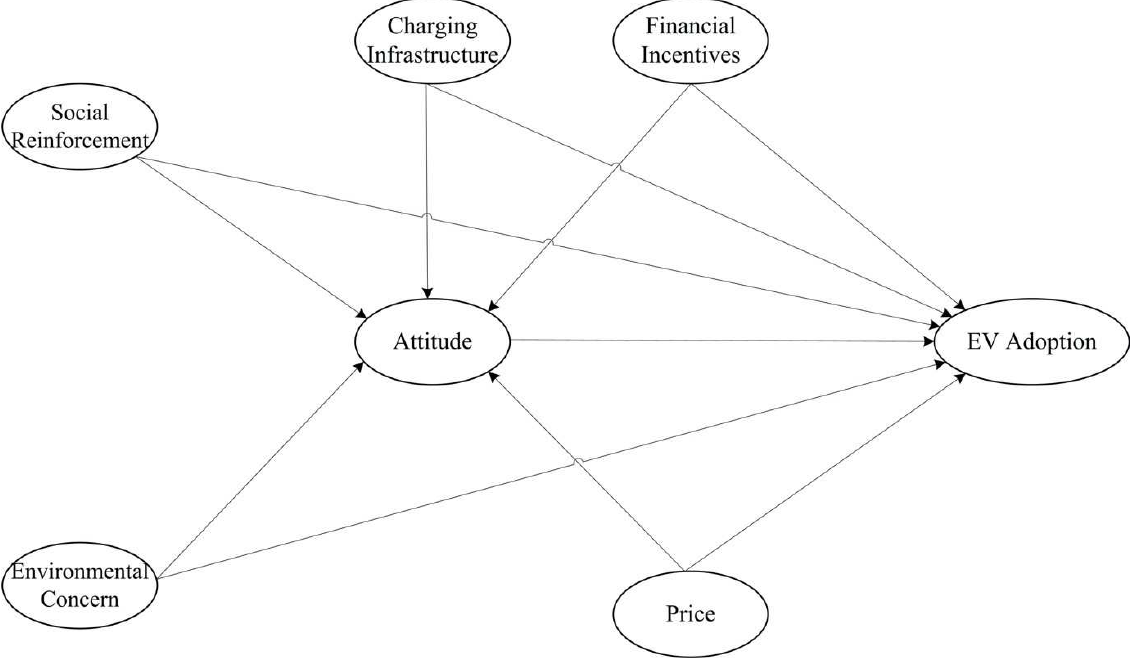
Figure 1. Proposed research